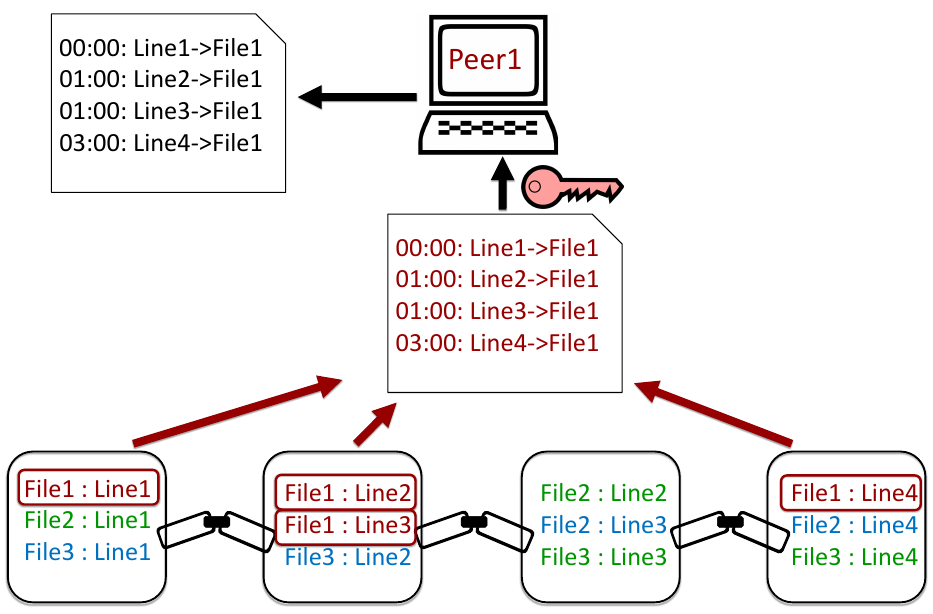
Figure 3. To reconstruct a log file, first the relevant lines of the file are gathered from the various blocks and ordered by their timestamps. The organization or peer that wrote the file will then use their unique private key to decrypt the file in order to recover the